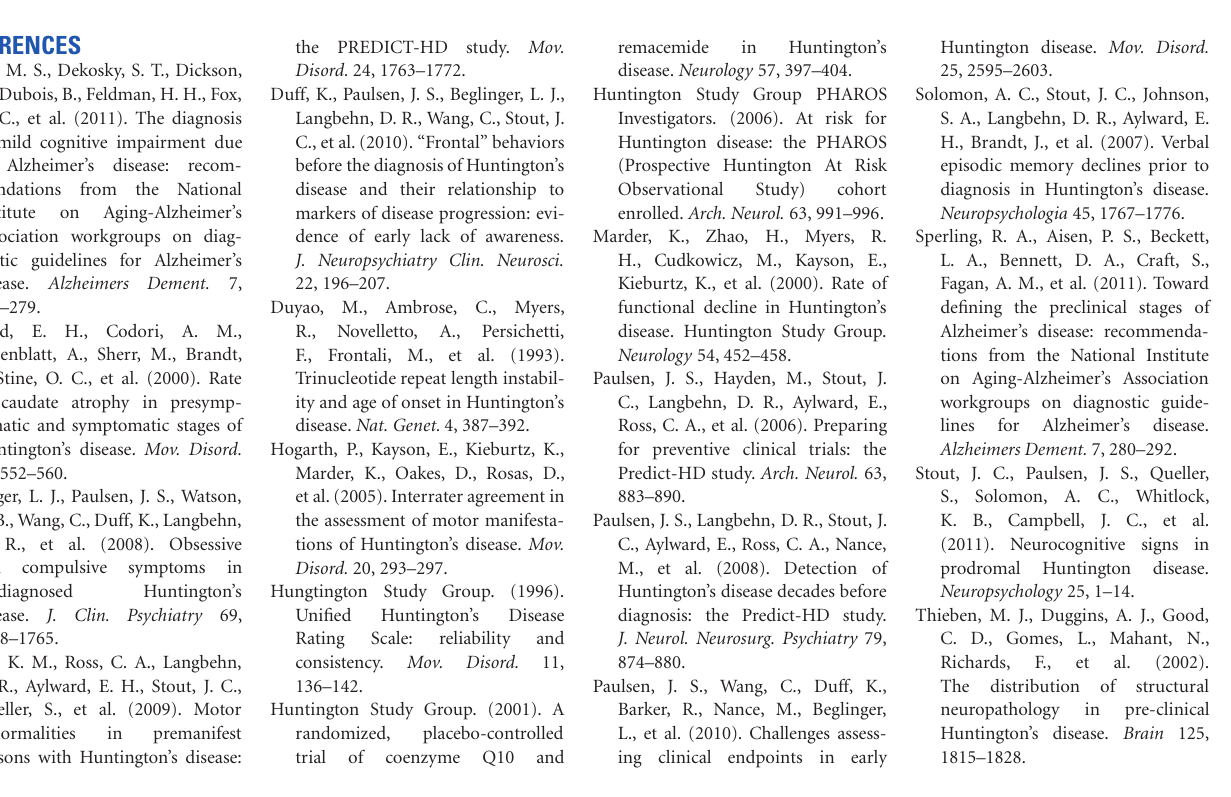
Table e-1 | Functional status by clusters. Table e-2 | Proportion of same versus different raters by cluster *